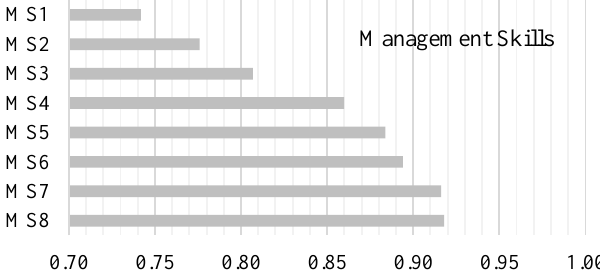
Fig. 2. Relative importance index obtained for management skills